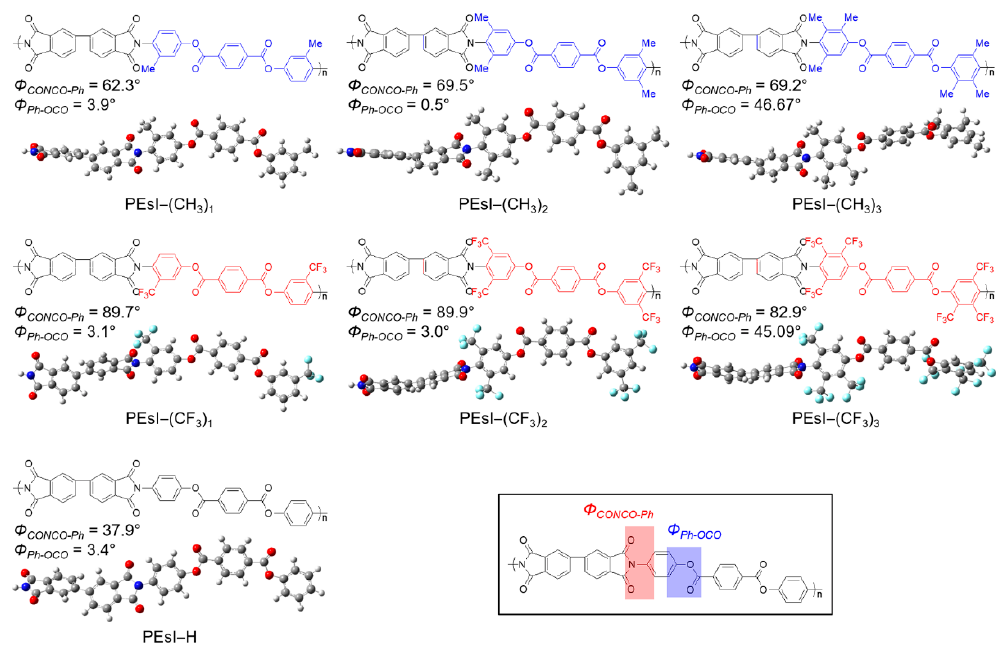
Figure 1. Chemical structures and three-dimensional (3D) molecular structures of the model compounds for the poly(ester imide) (PEsI) systems.